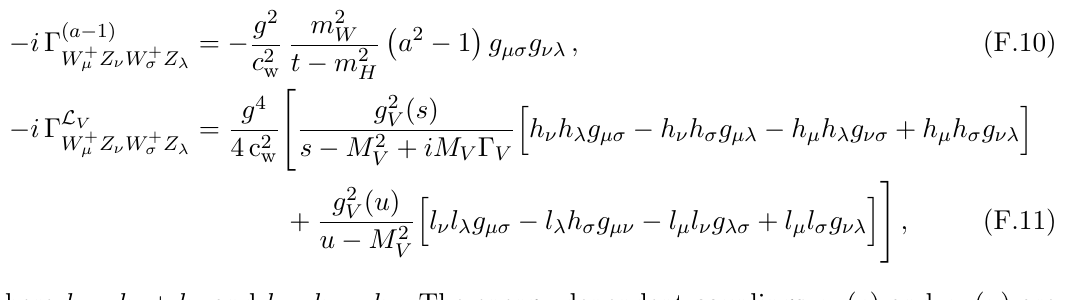
WZ ) IAM (cid:0) MC amplitude in the tree ! L V